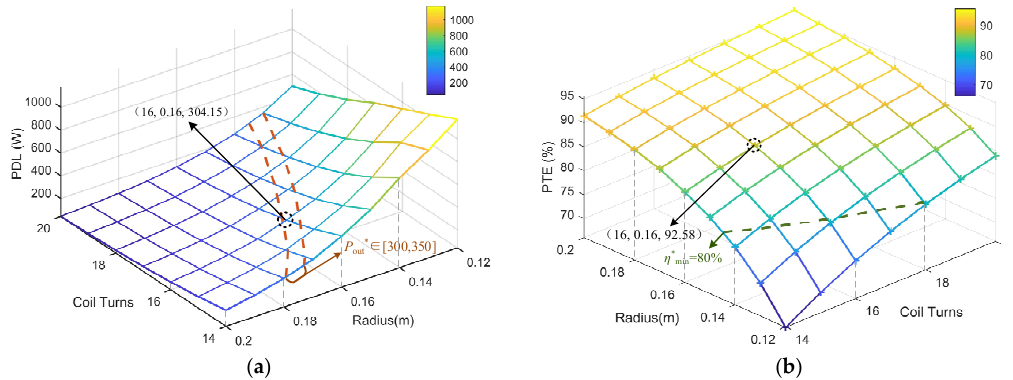
Figure 6. The PTE and PDL of coil models with the constrained coil parameters: ( a ) PDL; ( b ) PTE.